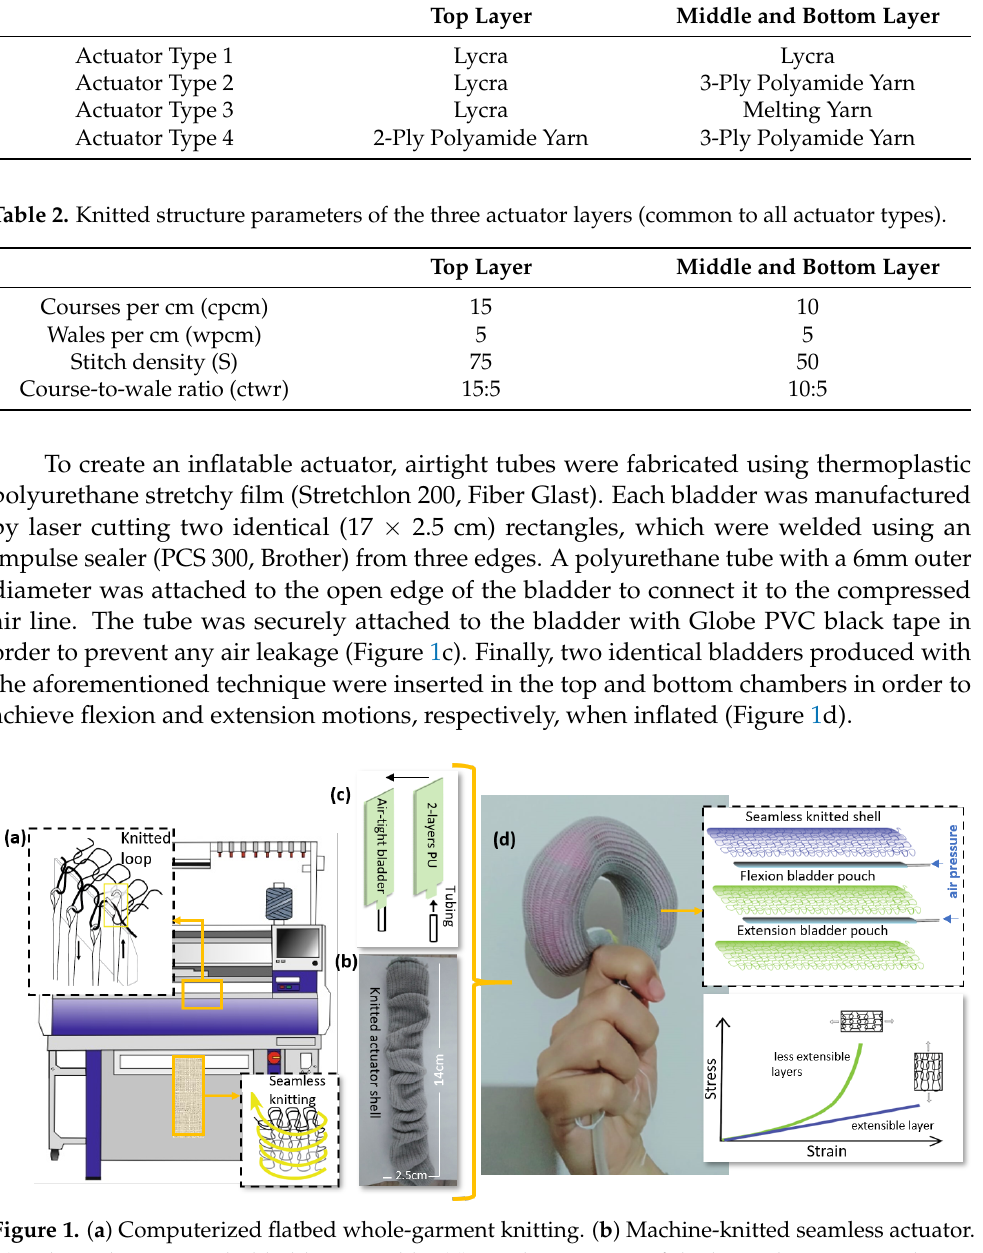
Figure 1. ( a ) Computerized flatbed whole-garment knitting. ( b ) Machine-knitted seamless actuator. ( c ) Polyurethane air-tight bladder assembly. ( d ) Bending motion of the knitted actuator under air pressurization and a construction principle based on an extensible top layer and less extensible middle and bottom